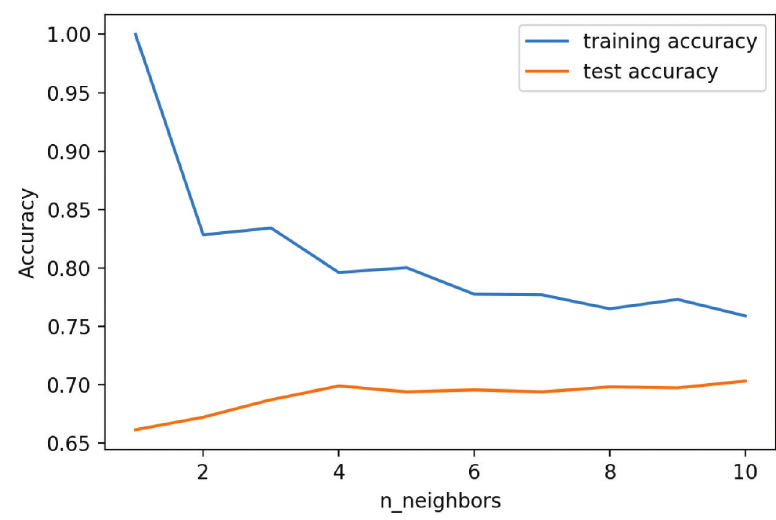
Figure 3. Accuracy curve of the training set and the test set of the F2 model.